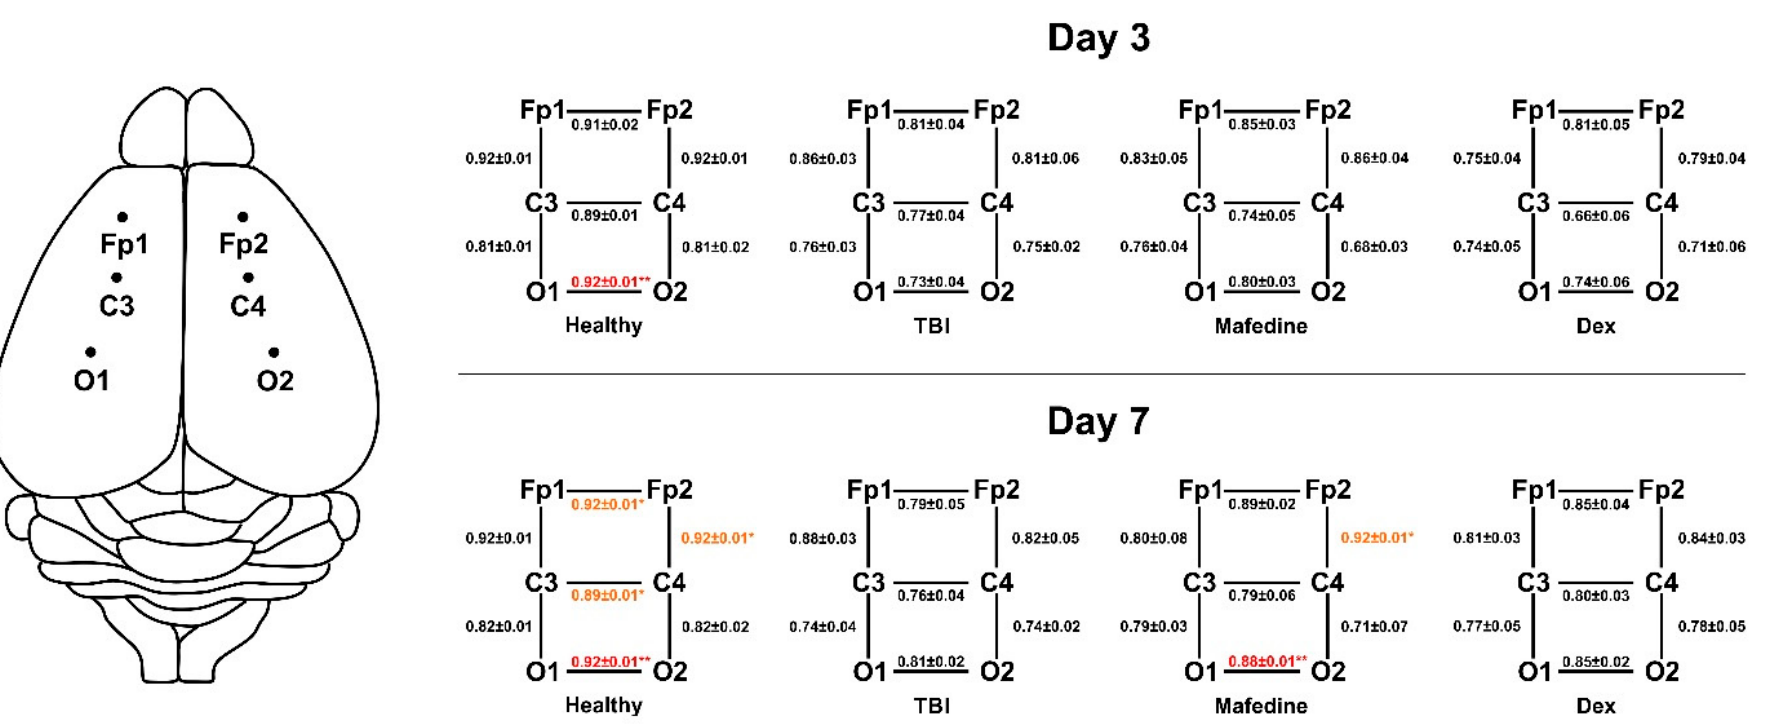
Figure 4. Ccr values for electrode pairs FP1-FP2, C3-C4, O1-O2, FP1-C3, FP2-C4, C3-O1, and C4-O2 at post-TBI days 3 and 7. Left: active electrode placement layout. Dex dexmedetomidine; * p < 0.05, ** p <0.01 vs. TBI.